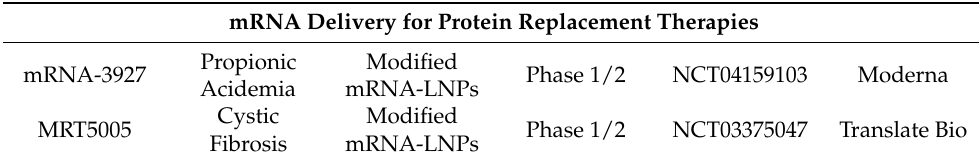
Table 3. mRNA Nanomedicines for Protein Replacement Therapies in Clinical Trials. A list of clinical trials for protein replacement applications is provided in this